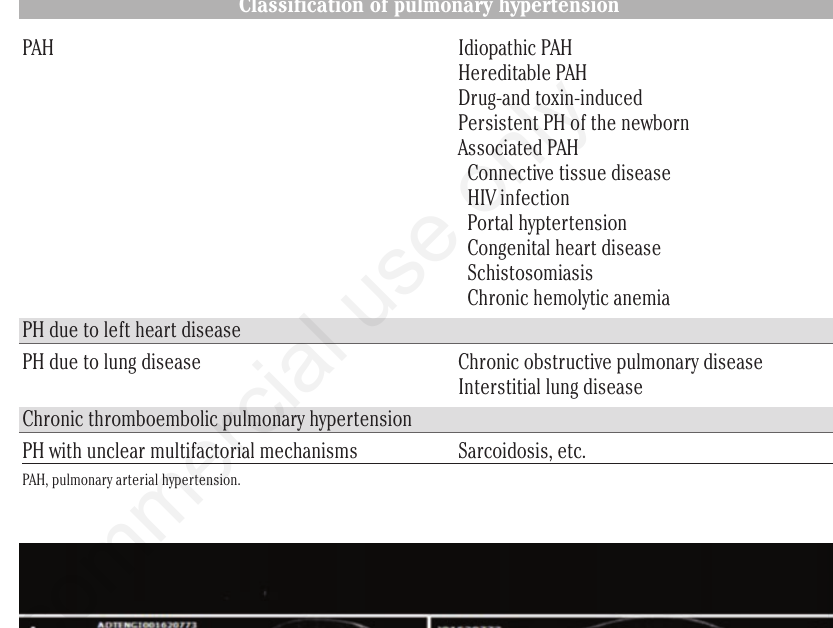
Table 1. Clinical classification of pulmonary hypertension according to the European Society of Cardiology (ESC) and the European Respiratory Society (ERS) guidelines. 1 Classification of pulmonary hypertension